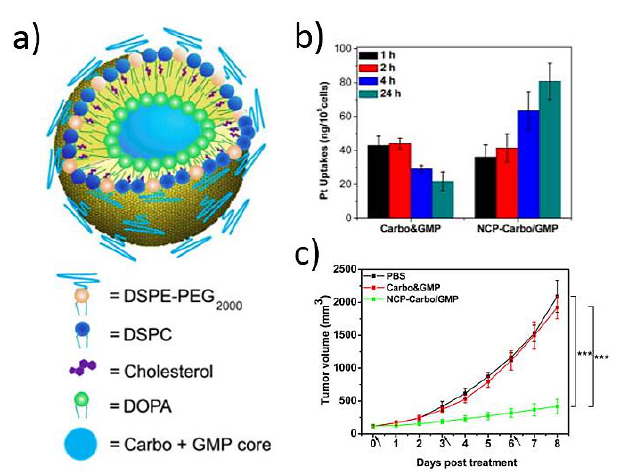
Figure 3. ( a ) Schematic of carboplatin and gemcitabine bearing NCPs (NCP-Carbo / GMP). ( b ) Cellular uptake of Carbo and GMP and NCP-Carbo / GMP in SKOV-3 cells determined by inductively coupled plasma mass spectrometry (ICP-MS). ( c ) In vivo tumor growth inhibition with a mixture Carbo and gemcitabine and NCP-Carbo / GMP administered on days 0, 3, and 6. Data are expressed as means ± SD ( n = 5). The figure is reproduced from Reference [44] with the permission from American Chemical Society.